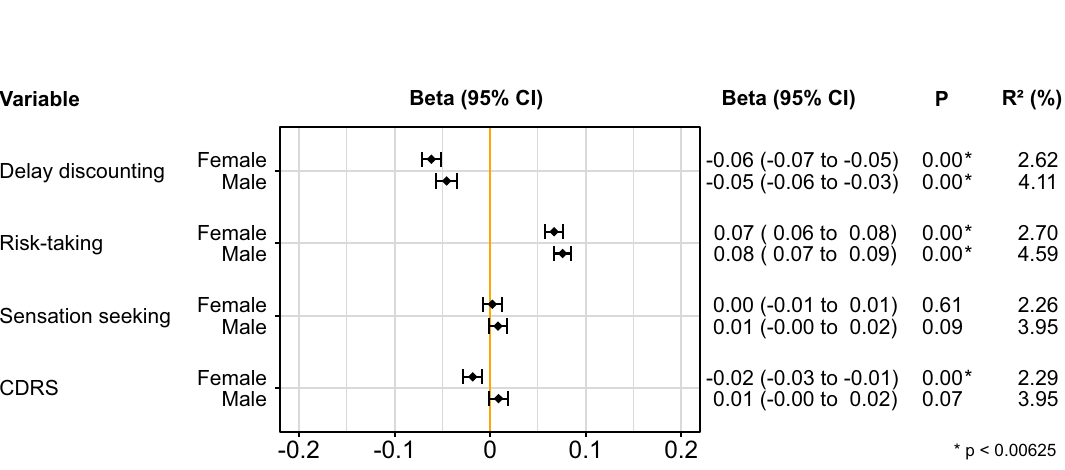
Figure 1. Beta estimates and confidence intervals (CI) of the associations between the DRS-traits and CDRS, with job satisfaction. The variables are standardized, thus representing the change in job satisfaction associated with each standard deviation increase of the respective variable. CDRS combined delay discounting, risk-taking and sensation